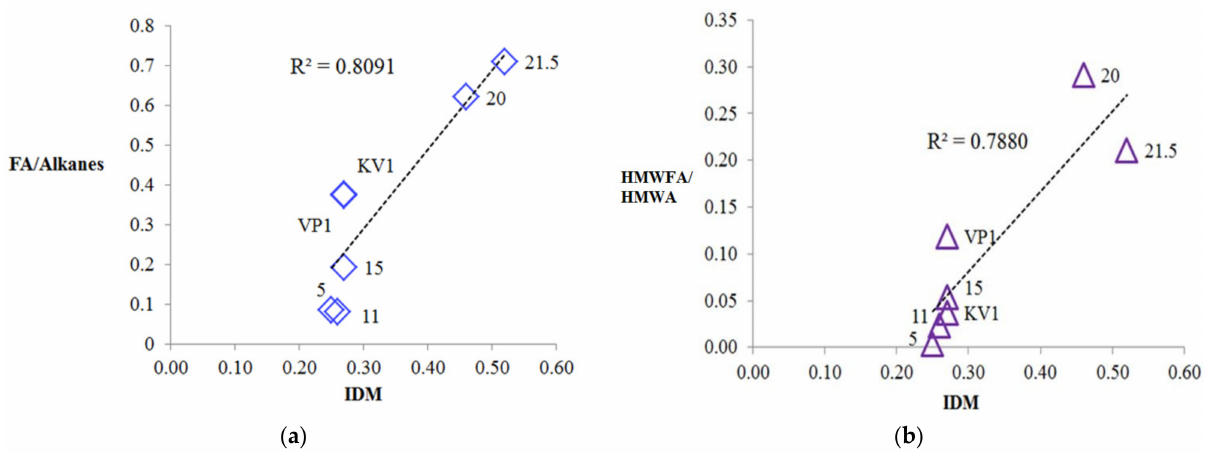
Figure 12. Relationships between IDM index and indexes based on relation fatty acids to n-alkanes: ( a ) Correlation between IDM and FA/Alkanes ratio; ( b ) correlation between IDM and high molecular weight n-fatty acids (HMWFA)/high molecular weight n-alkanes (HMWA)